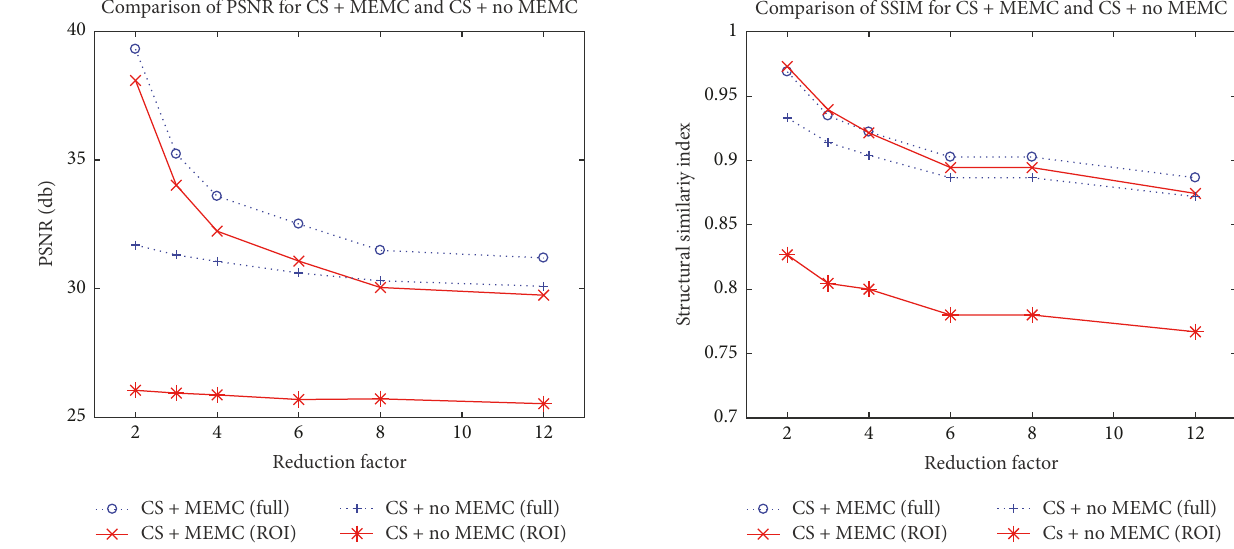
Figure 6: Performance comparison of PSNR at different reduction factors for CS-free breathing (CS + no MEMC) and CS-free breathing motion corrected (CS + MEMC). Dotted lines depict PSNR over the full image and solid lines show PSNR in the region of interest (ROI).